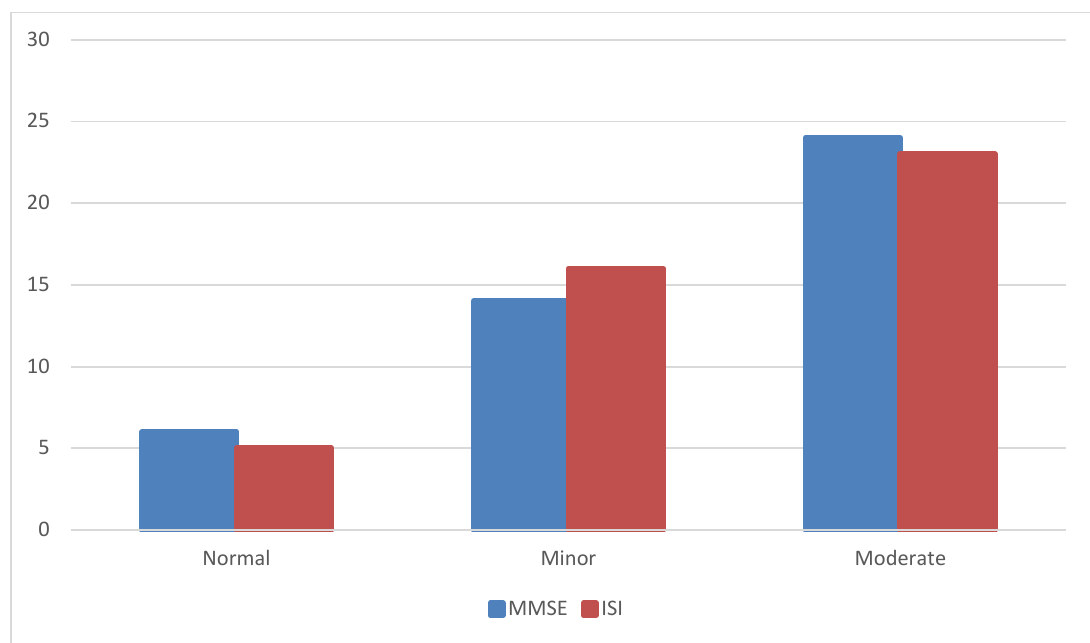
Figure 1 . Frequency of Respondents Based on Cognitive Values and Sleep